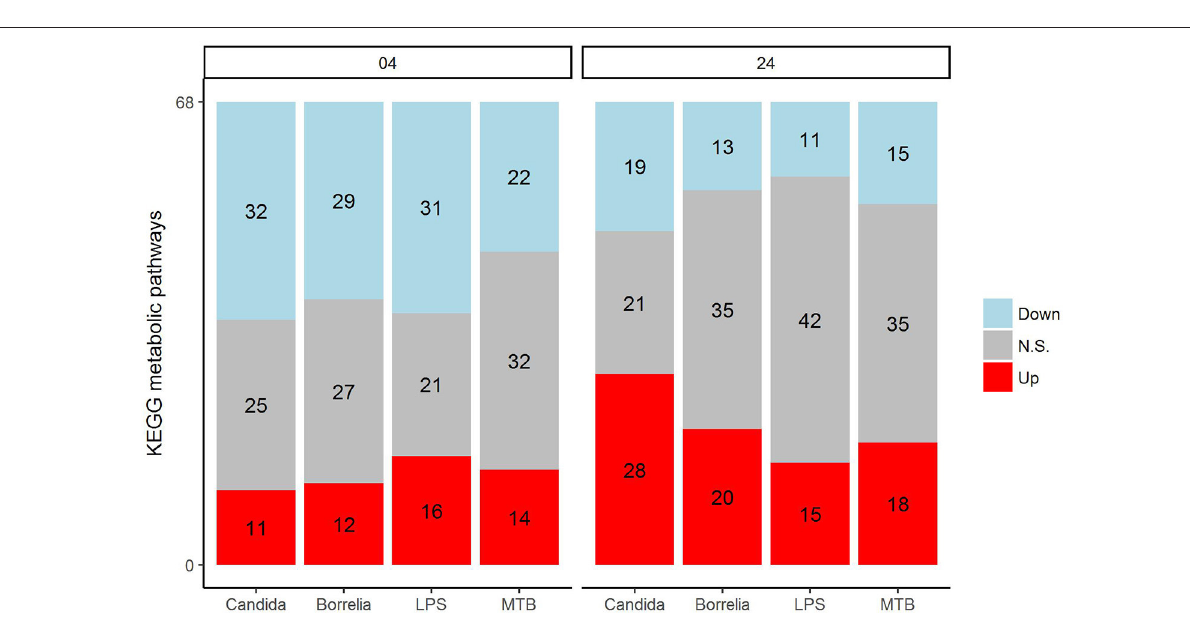
and MTB, but differed from Candida -stimulated PBMCs